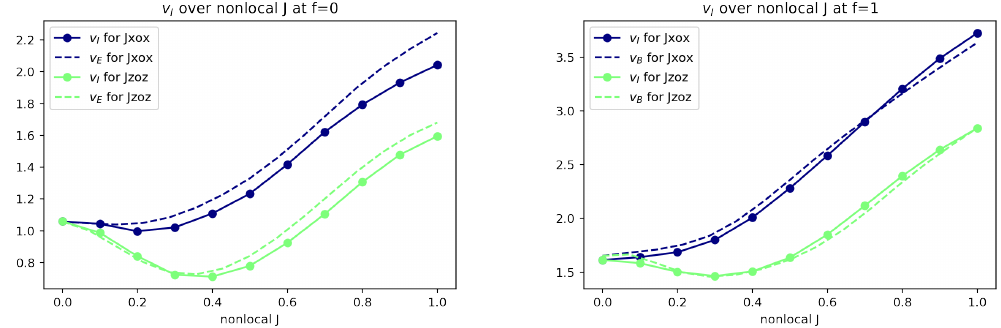
Figure 4 . Left: information velocity as a function of nonlocal coupling ( J xox or J zoz ) at fixed f = 0 . The dashed lines in this panel are an independent computation of v E values in the presence of the same nonlocal couplings. Right: information velocity as a function of nonlocal coupling ( J xox or J zoz ) at fixed f = 1 . The dashed lines in this panel are an independent computation of v B values in the presence of the same nonlocal